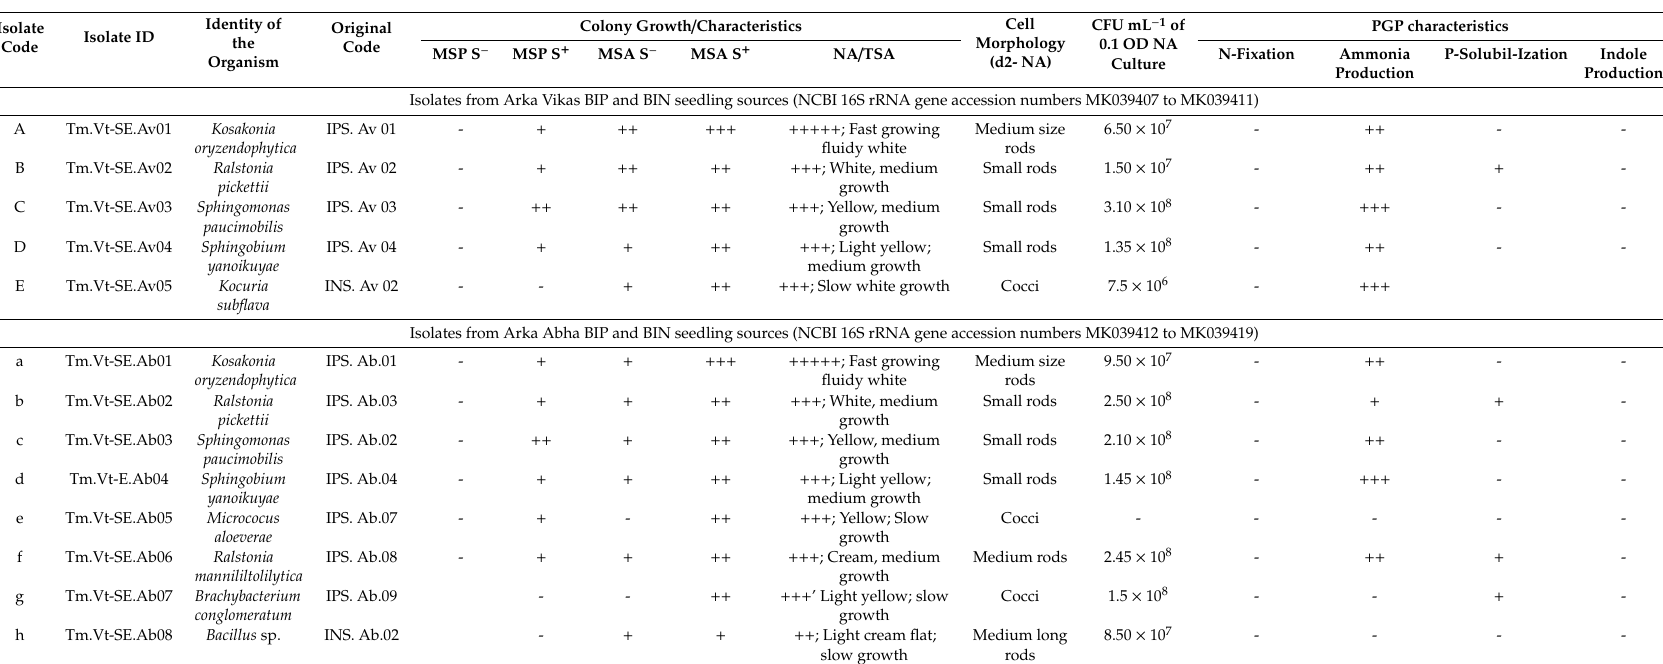
Medium long - - - slow growth rods